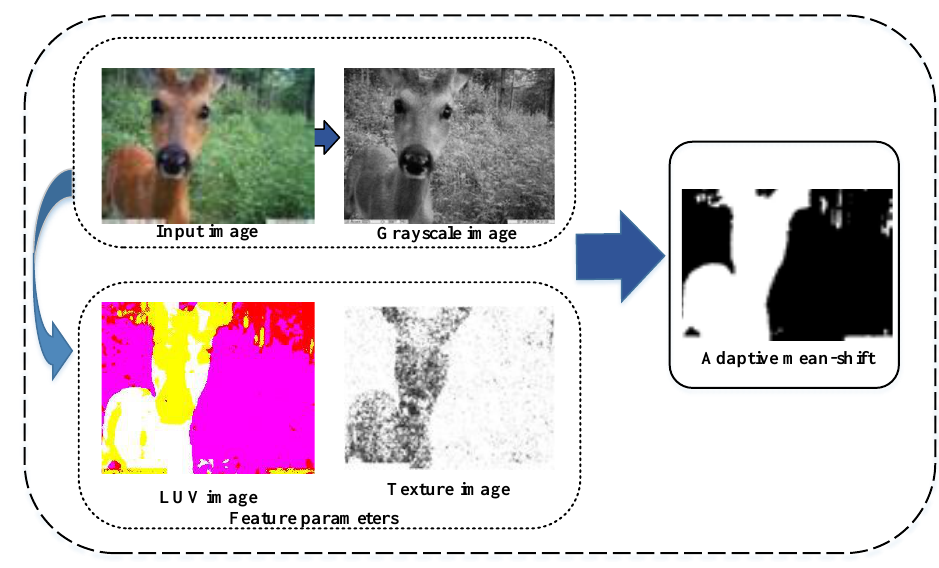
Figure 3. Flow-process diagram of the proposed method; LUV:CIELUV.